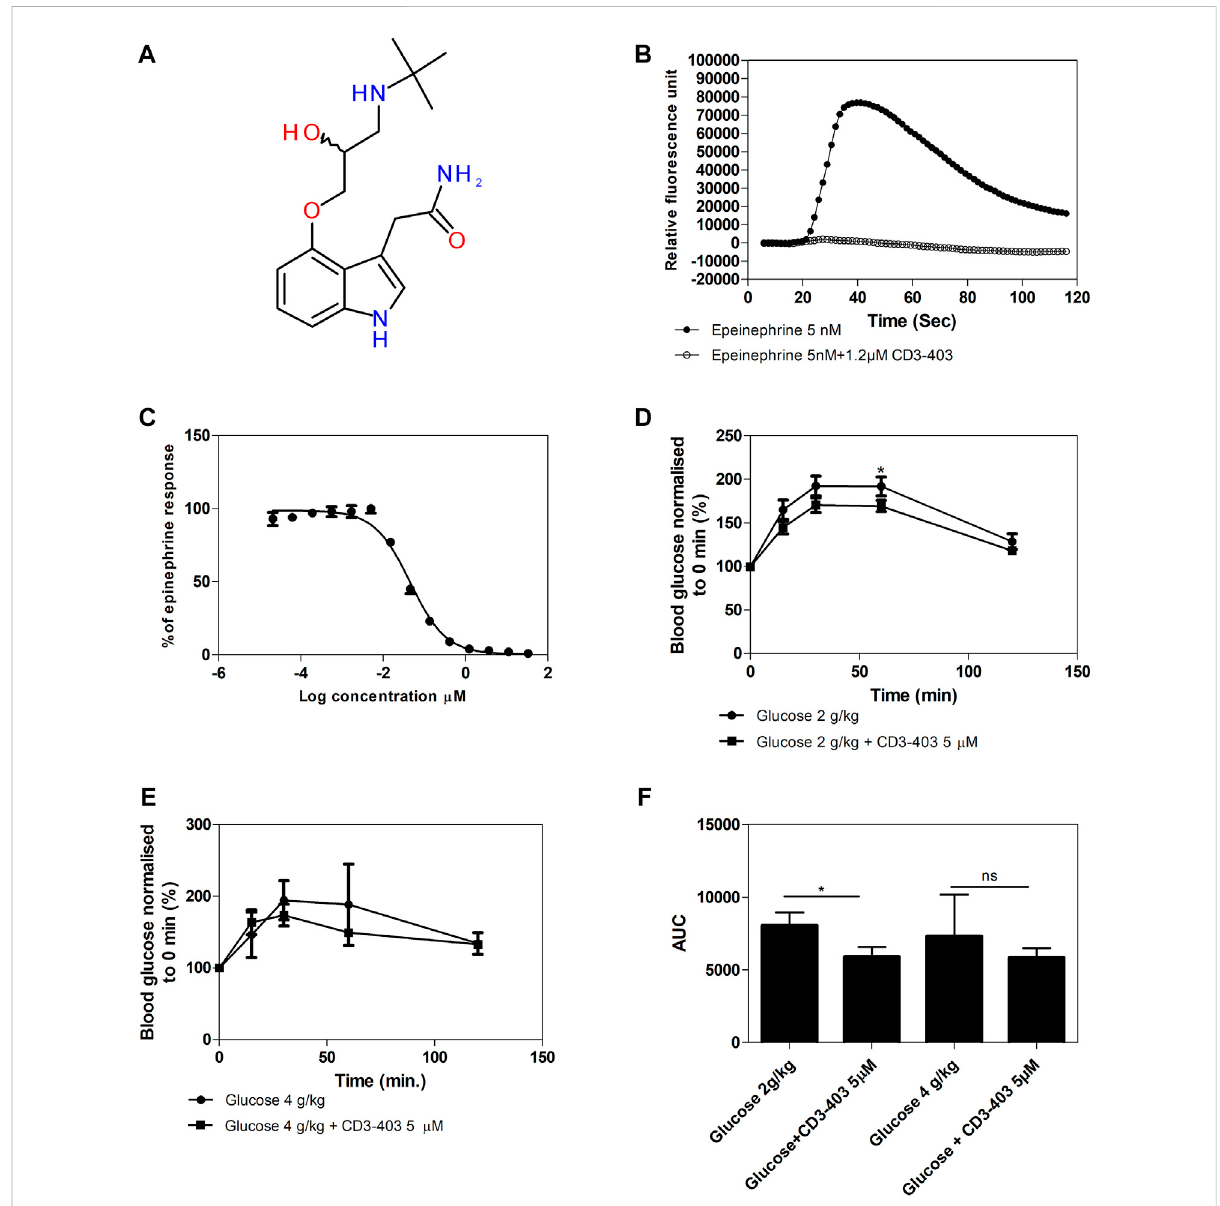
FIGURE 7 Blood glucose levels after administration of glucose to rats in the presence and absence the non-bioavailable β -AR antagonist CD3-403. (A) Structure of the non-bioavailable β -AR antagonist CD3-403, a modi fi ed, more polar derivative of ICI 118,551. (B) CD3-403 inhibits epinephrine- elicited β 2 -AR-mediated calcium response in vitro in Flp-In-293 cells. X -axis shows time in s, and y -axis displays fl uorescence intensities (arbitrary units) for 5 nM epinephrine and 5 nM epinephrine +1.2 µM CD3-403 (representative graph from n = 3). (C) Concentration response curve for CD3-403 inhibition in Flp-In-293 cells, IC 50 = 46 ± 5 nM. X -axis shows log concentration CD3-403 (µM) and y -axis displays fl uorescence intensities (arbitrary units), normalized to epinephrine response, which was set at 100% ( n = 3). (D,E) A bolus of glucose 2 g/kg body weight (4 sets of 3 rats), (D) or 4 g/kg body weight (1 set of 3 rats), (E) was administered orally to sets of rats in the absence or presence of 5 µM (.05 mg/kg) CD3-403. Glucose levels were measured in blood drawn from the tail vein at different time points after oral administration of the glucose bolus. The increase in blood glucose concentration is shown after the glucose load, normalized to the 0 min blood glucose concentration of 82 mg/dl for the whole group of 2 g/kgbody weight and85 mg/dl forthewholegroup of4 g/kgbodyweight withorwithoutCD3-403treatment,which wassetat100%.( F) ,Forthe experiment with glucose 2 g/kg, the area under the curve (AUC in units of blood glucose %. min) was calculated by setting 100% as a baseline. All values are expressed as mean ± SEM, p < .05: *. In case of the in vivo glucose bolus administration, the direction of the effect that we wanted to test was known, i.e. inhibition by CD3-403, hence a one tailed t -test was